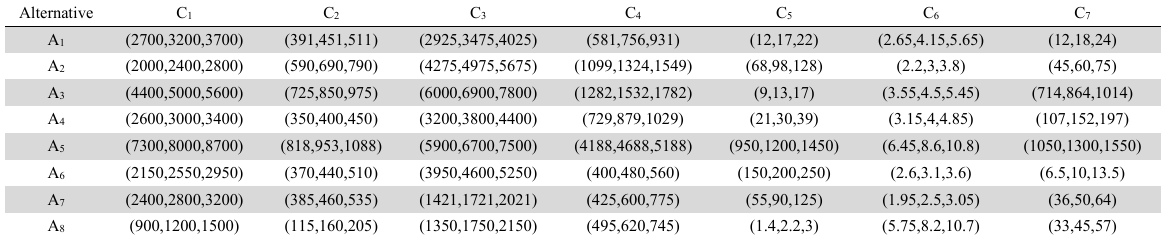
Fuzzy decision matrix for grinding wheel abrasive material selection problem Alternative